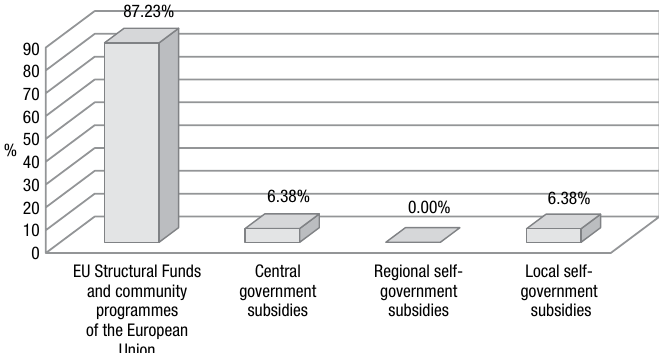
Fig. 3. Percentage of public funds in the cluster budgets in the countries of moderate innovators